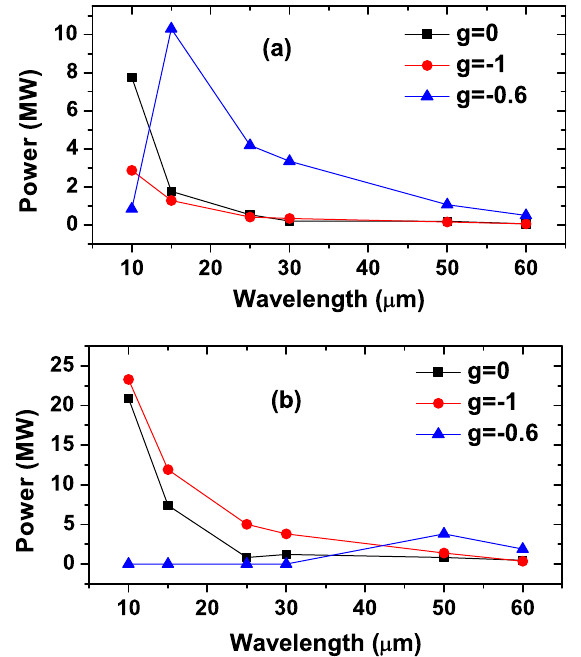
FIG. 7. Mode profiles from the simulations at a wavelength of 25 μ m and a hole size of 1 mm, for the (a) confocal ( g ¼ 0 ), (b) concentric ( g ¼ − 1 ) and (c) intermediate ( g ¼ − 0 . 6 ) con- figurations. For each plot the window size is 50 mm by 50 mm.